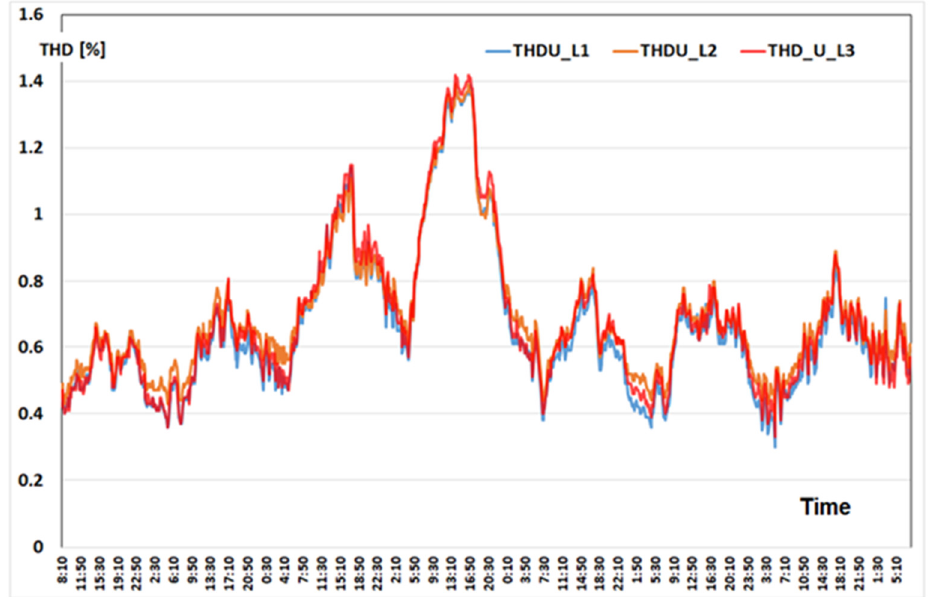
Figure 12. Changes in the total harmonic distortion THD U recorded in three phases of the steel supply network during the week of measurements.